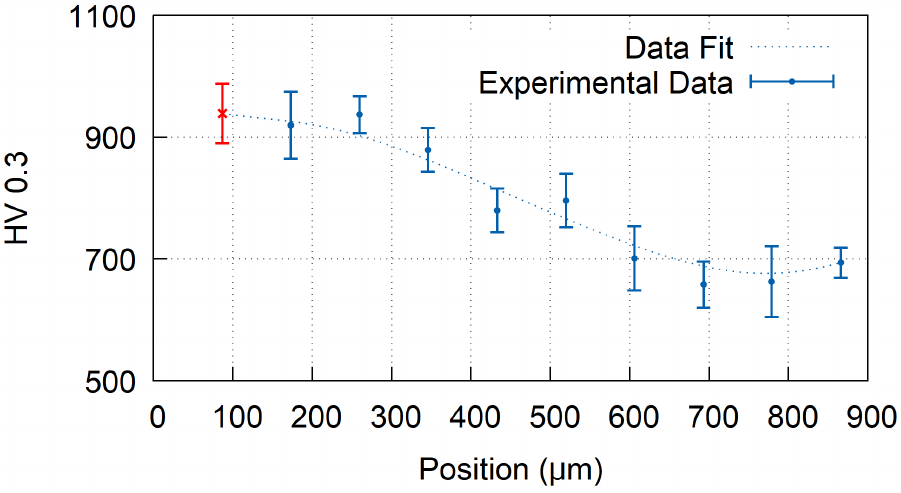
Figure 7. Microhardness profile of the laser heat treated sample L4. For samples with gradient hardness, the value closest to the surface (red color) was taken as reference.